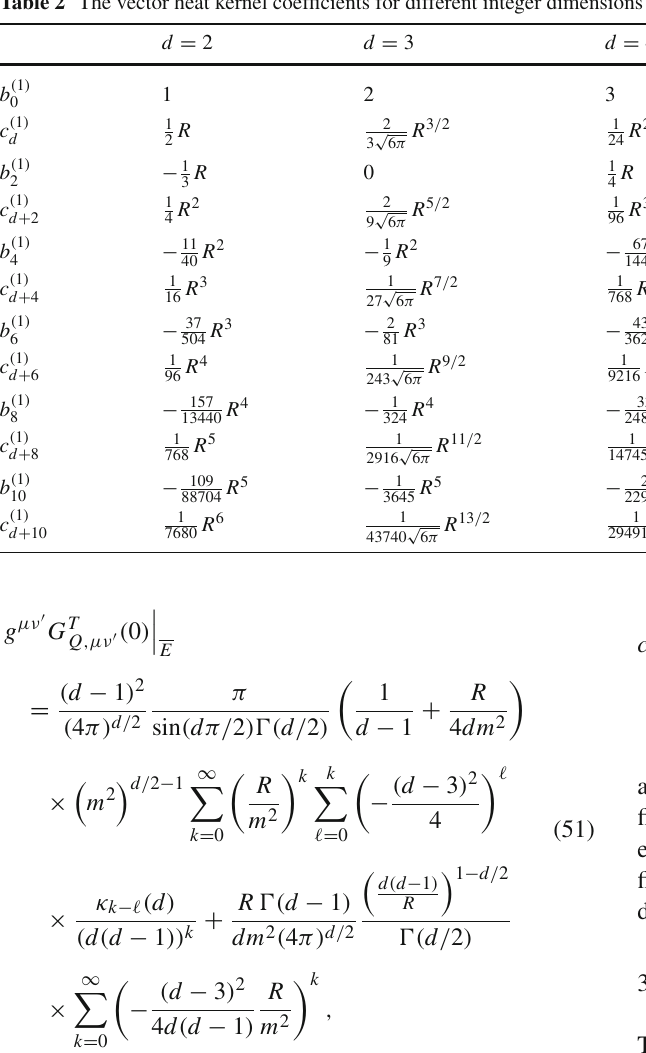
Table 2 The vector heat kernel coefficients for different integer dimensions and vanishing